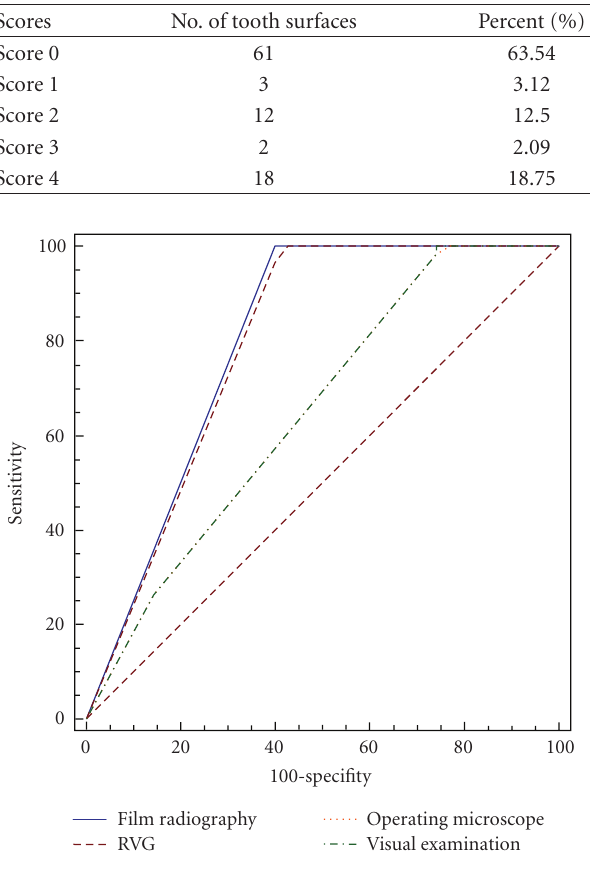
Table 2: Histological examination of the teeth.